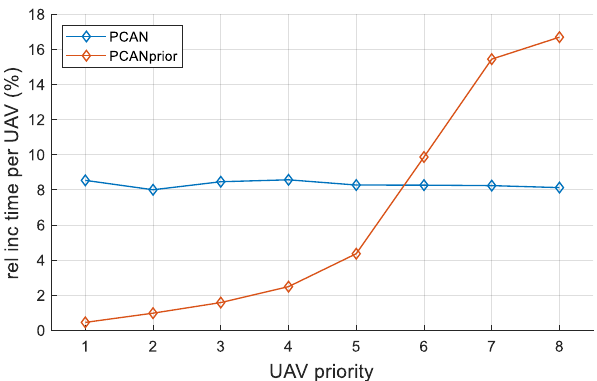
Figure 7. Relative increment in time, compared with the direct algorithm, by UAV priority classes.